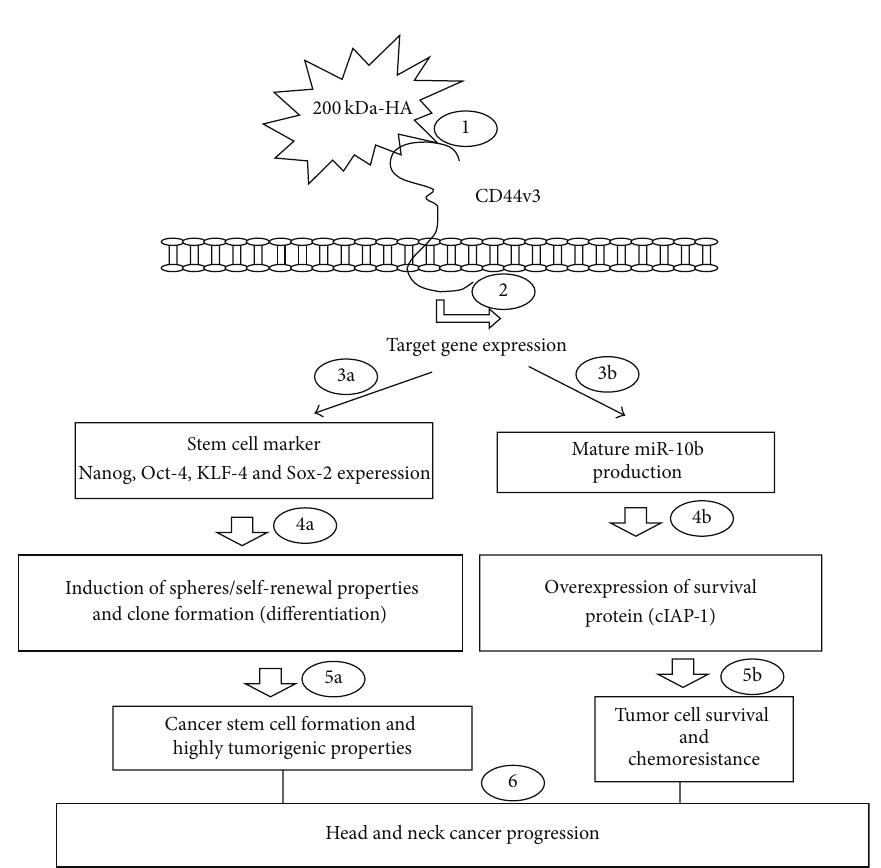
Figure 8: A proposed model for oncogenic signaling induced by 200kDa-HA in the regulation of miRNA-10 production and cancer stem cell (CSC) functions in CD 44 v 3 high ALDH high cells. The binding of 200 kDa-HA (step 1) to CD 44 v 3 high ALDH 1 high cells promotes specific target gene expression (step 2), including stem cell marker (Nanog, Oct-4, KLF-4 and Sox-2) experession (step 3-a). The resultant stem cell marker expression then induces spheres/self-renewal properties and clone formation (differentiation) (step 4-a) contributing to cancer stem cell formation and highly tumorigenic properties (step 5-a). At the same time, the binding of 200 kDa-HA to CD 44 v 3 high ALDH 1 high cells also stimulates miR-10b gene expression/mature miR-10b production (step 3-b) which then stimulates survival protein, IAP (c-IAP1) expression (step 4-b), and HNSCC cell antiapoptosis/survival as well as chemoresistance (step 5-b). Taken together, these findings suggest that HA- (in particular, 200 kDa-HA-) mediated cancer stem cell (CSC) pathways and miR-10b function play a critical role in promoting tumor formation and chemoresistance leading to head and neck cancer progression (step